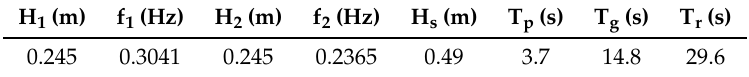
Table 2. Target values of wave condition